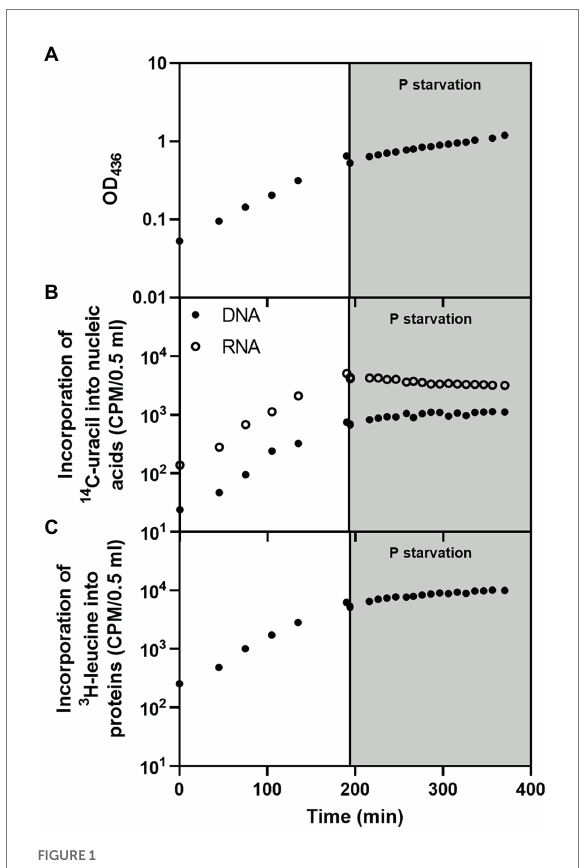
FIGURE 1 Macromolecular profile of E. coli MAS1190 ( Δ argG Δ leuA Δ pyrE::tet ) during balanced growth (white background) and after filtration into P-free medium (gray background). The panels show (A) optical density of the culture, (B) 14 C-uracil incorporated into DNA (filled circles) and RNA (open circles), and (C) 3 H-leucine incorporated into protein. The data set presented in this figure is representative of three independent biological replicates with similar results. The replicate experiments are shown in Supplementary Figure S1. Cells grew with a doubling time of ~57 min prior to starvation. The minor drop observed in all measurements immediately upon starvation was caused by the loss of cells during filtration. Note the logarithmic scale on the